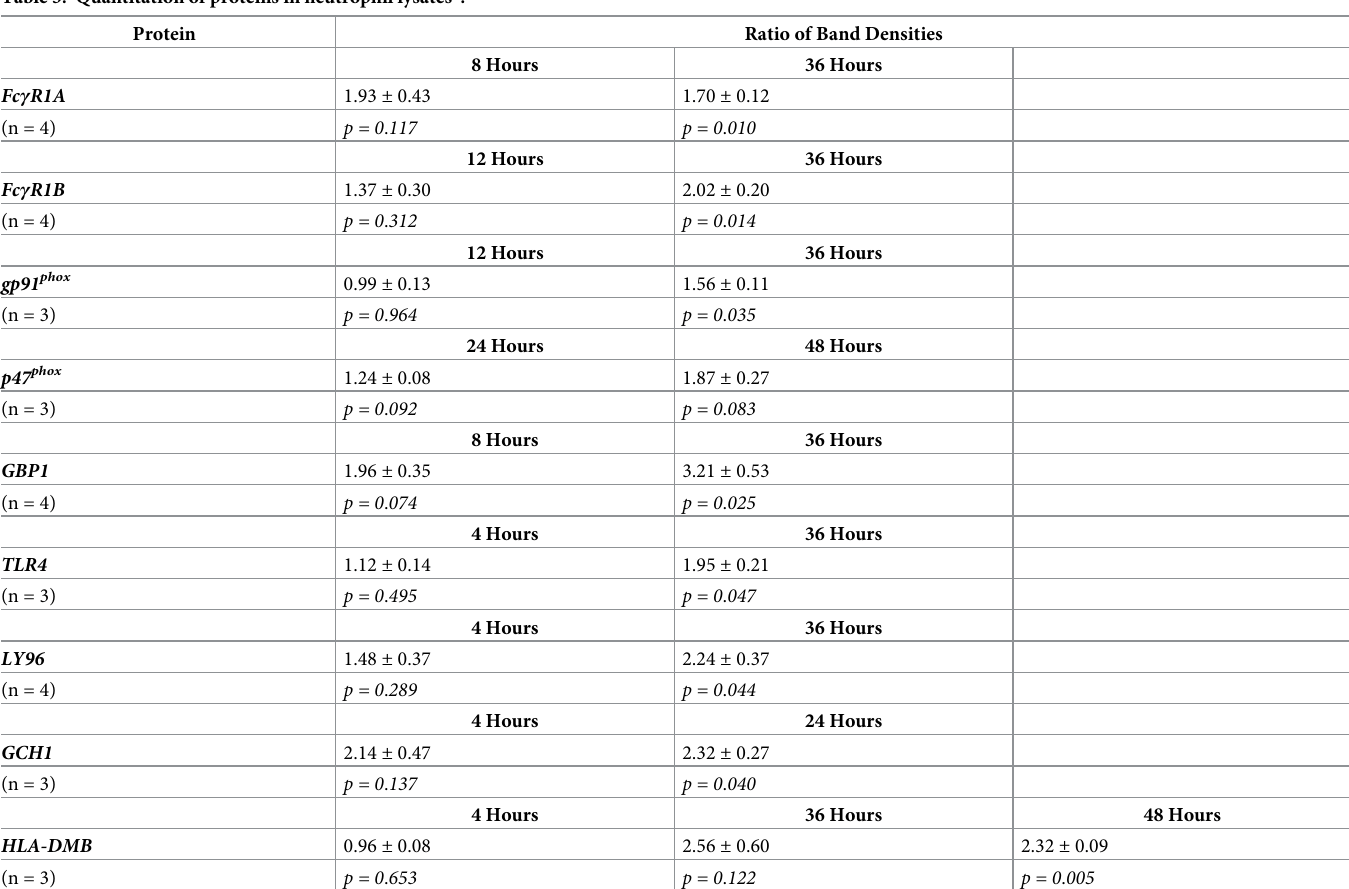
Table 3. Quantitation of proteins in neutrophil lysates � . Protein Ratio of Band